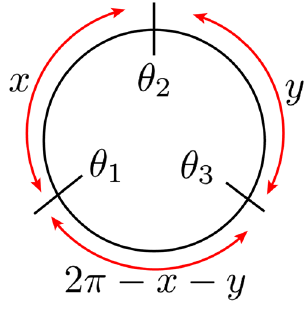
FIG. 7. Transformation between θ 1 , θ 2 , θ 3 and x , θ 2 , z .